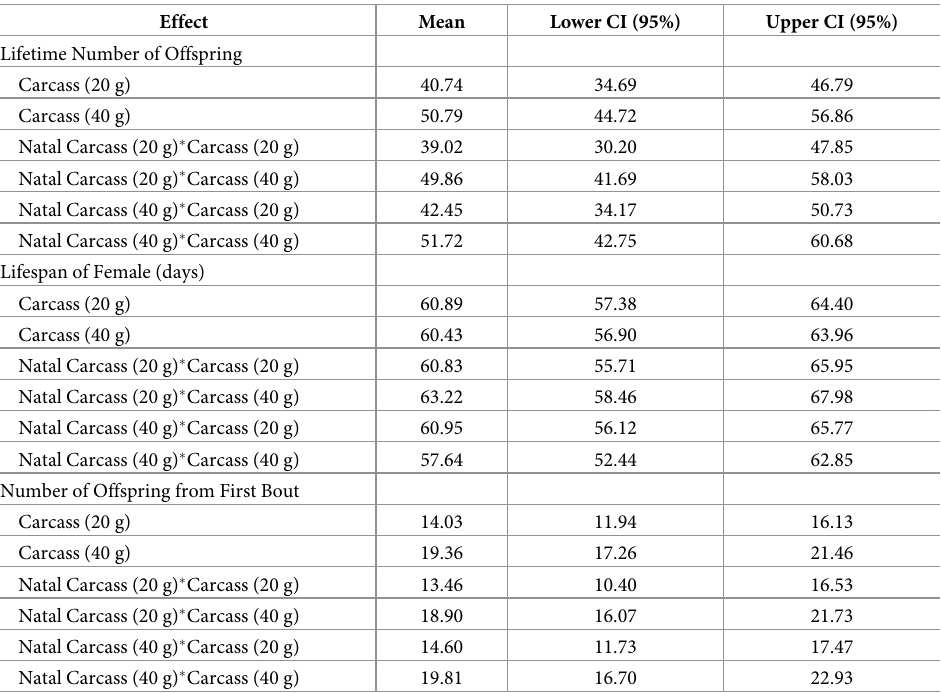
Table 2. Least squares means and upper and lower confidence intervals for main effects of current carcass size and the interaction between current carcass size and natal carcass size in N . marginatus .